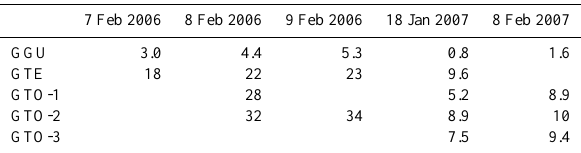
Table 5. Estimated daily glacier melting rates (mmw.e. per